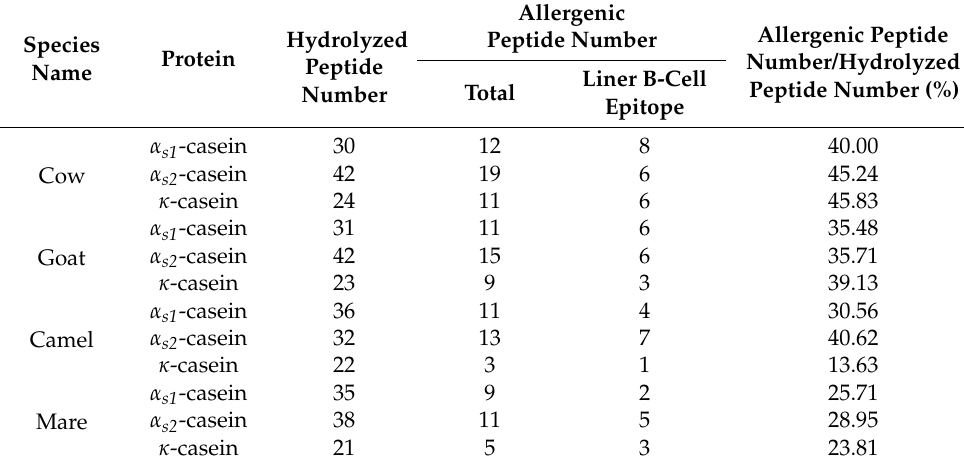
Table 3. The number and proportion between the hydrolyzed peptides and the allergenic peptides from allergenic subtypes in CM, GM, CAM, and MM, respectively. Among them, the hydrolyzed peptides and allergenic peptides were generated by simulating gastrointestinal (GI) tract hydrolysis, as well as allergenic peptide prediction, respectively. Allergenic peptides obtained from the linear B-cell epitope amino acid sequence were considered allergenic peptides that were derived from the linear B-cell